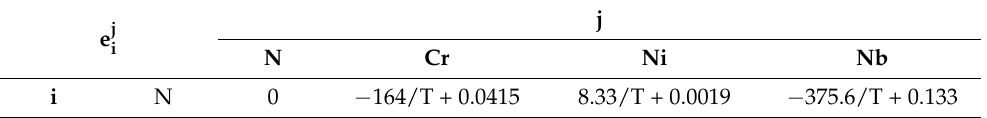
in liquid Fe-Cr-Ni-Nb system. Data from [10]. i